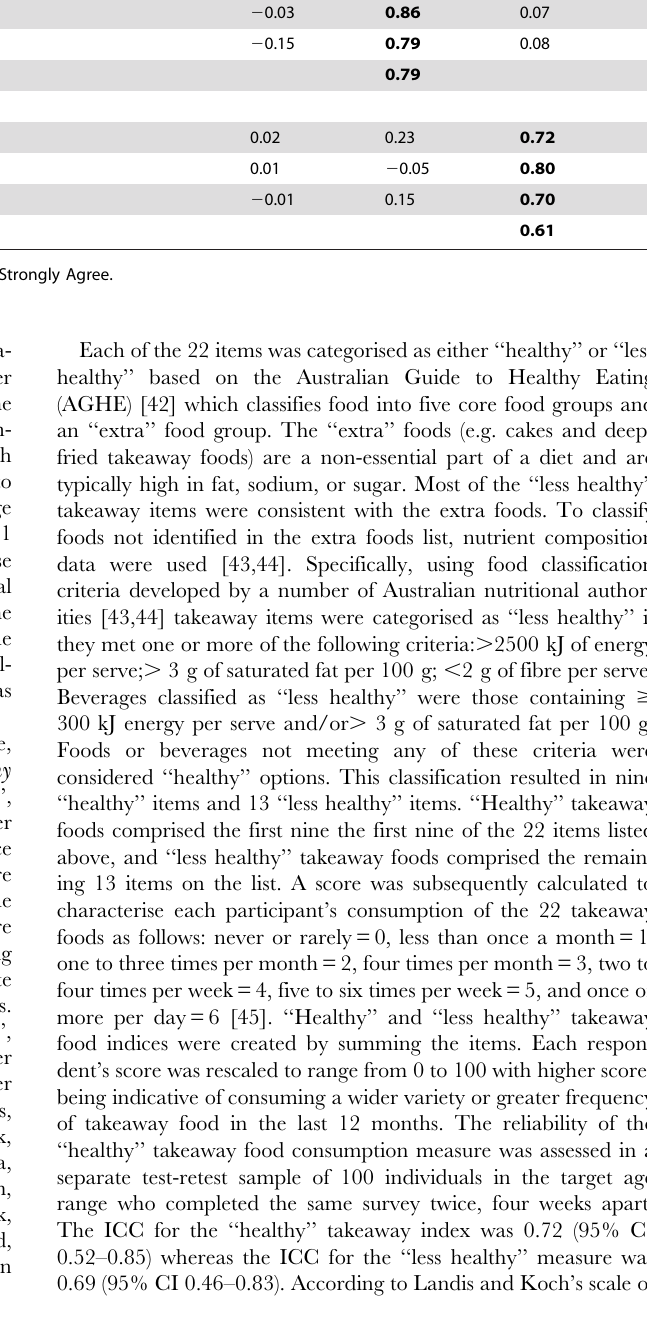
Table 1. Beliefs and perceptions about diet, health, and takeaway food: results of a Principal Components Analysis.